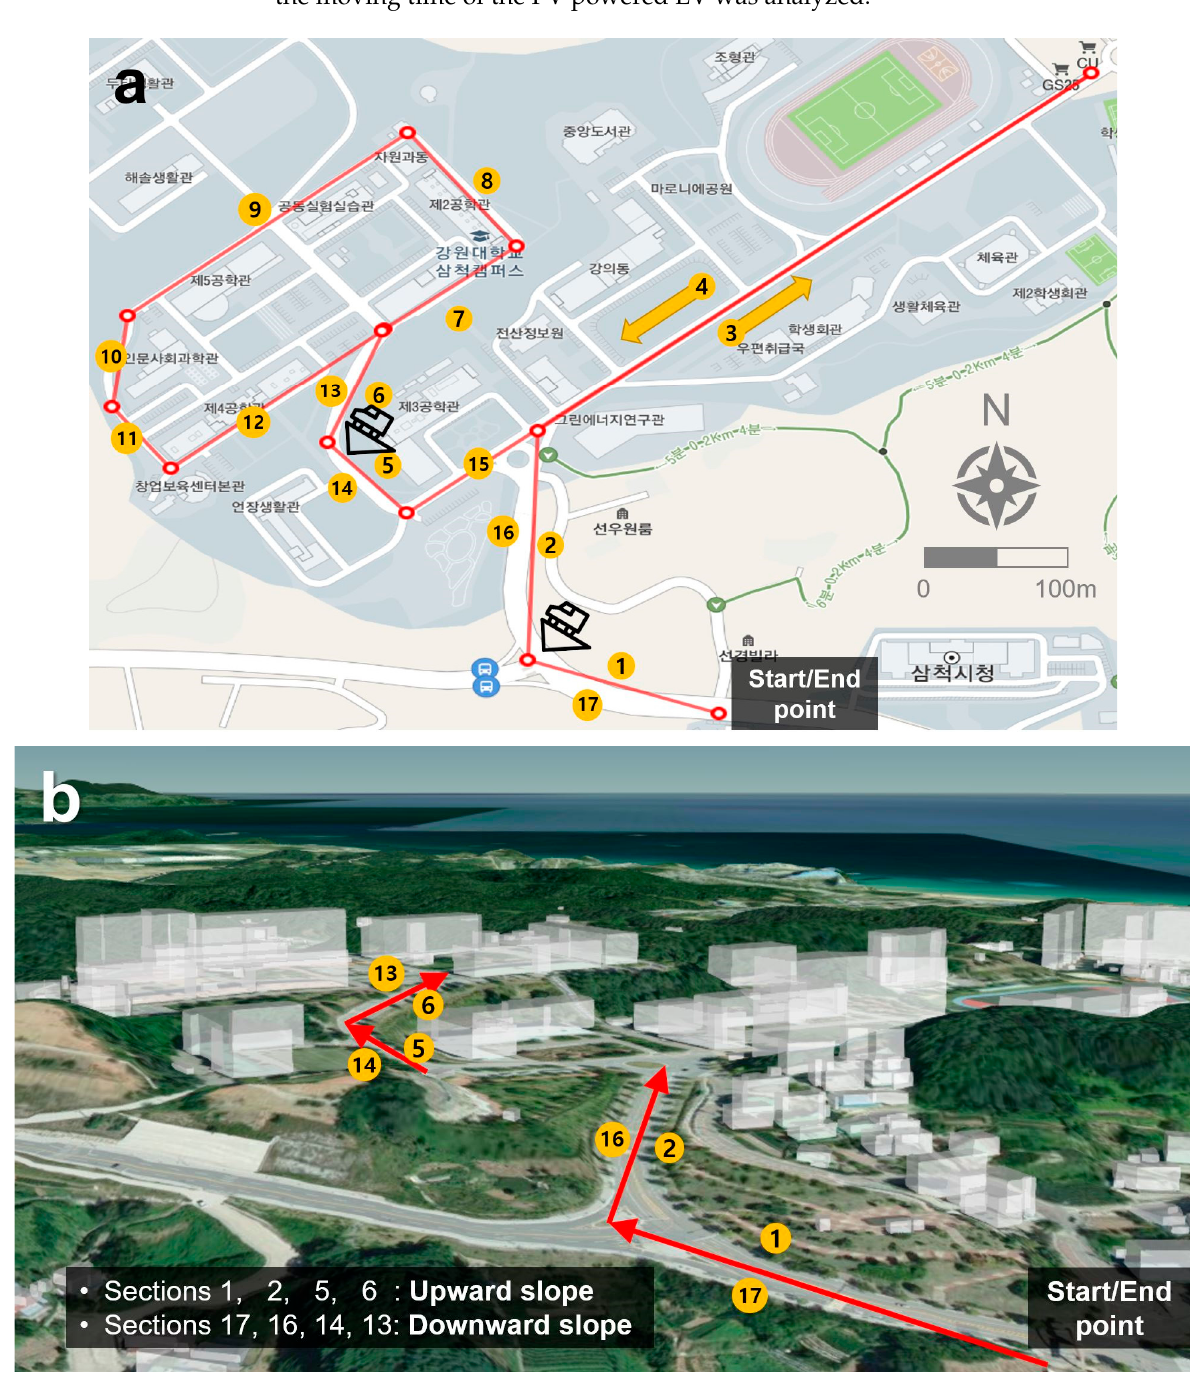
Figure 1. Study area ( a ) map with 17 driving sections with a different slope and azimuth (Korean labels in the map indicate the building name); ( b ) 3D aerial view of sloped roads (image sourced from https://www.vworld.kr/, accessed on 20 December 2022)